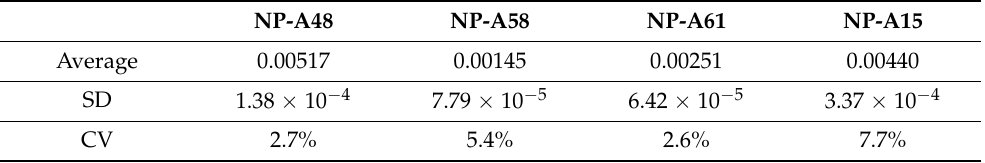
Table 2. The sensor responses in bioconjugation of four ssDNA aptamers (aptamer concentration = 1 µ M, n =